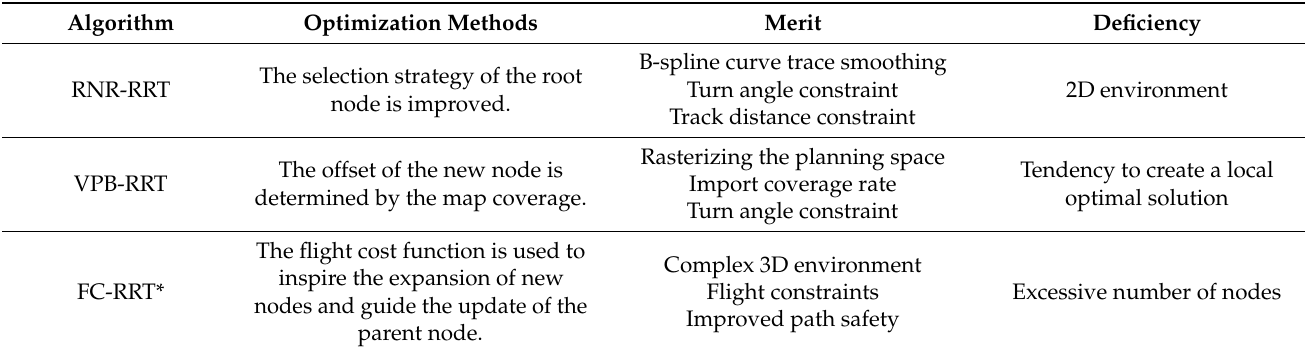
Table 1. Main aspects of the aforementioned